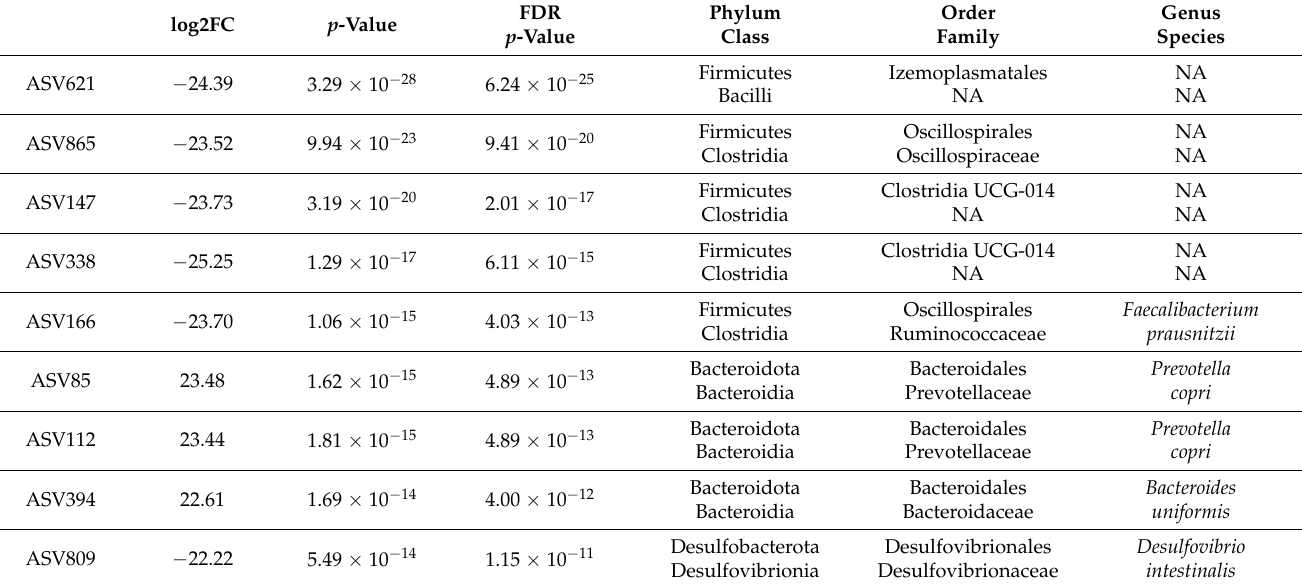
Figure 5. NMDS (non-metric multidimensional scaling) plot based on Bray–Curtis dissimilarity of the bacterial microbiota composition in study groups (R—responders, NR—non-responders, and C—controls). Permutation multivariate analysis of variance revealed significant differences between the groups (R 2 = 0.0491 and p = 0.0089). Table 3. Bacterial ASVs significantly enriched in responders (log 2 FC positive values) and non- responders (log 2 FC negative values).